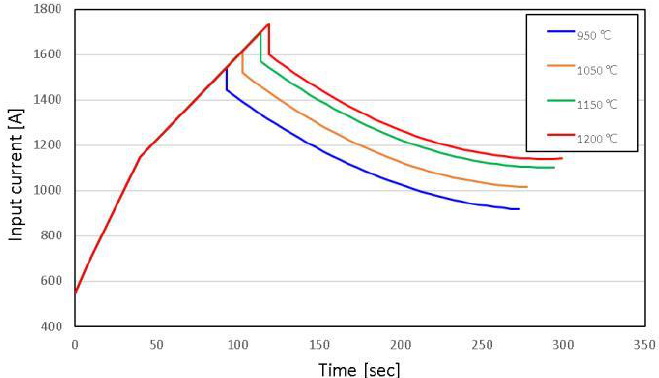
Figure 4. Input current for heating calculated by heat transfer analysis.